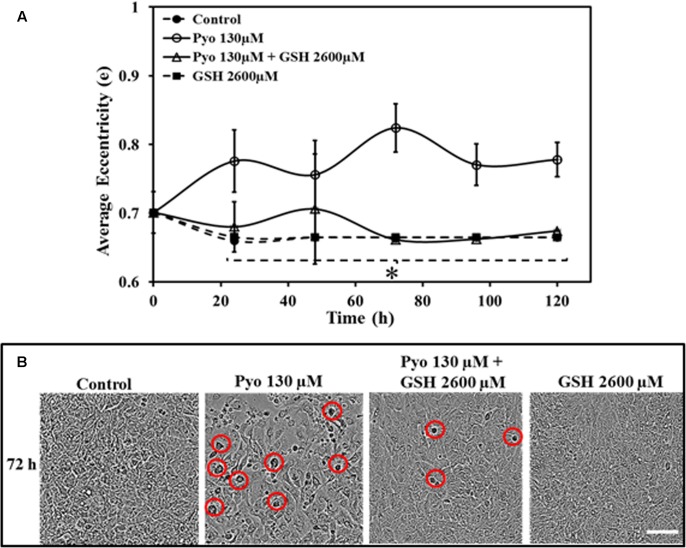
Effect of pyocyanin and GSH on A549 cell eccentricity over different time periods, monitored using IncuCyte Zoom live cell imaging. (A) Quantification of the average eccentricity of A549 confluence over 120 h. Control (untreated), GSH alone and pyocyanin + 2600 μM GSH-treated cells showed stable eccentricity, and the difference is significant in comparison to pyocyanin alone at all time-points. (B) Example showing 72 h images of A549 adherence, confluence and eccentricity in 96-well plates grown under different conditions. In comparison to the control, GSH alone and the pyocyanin + 2600 μM GSH, the pyocyanin only treated A549 cells showed considerably change in cell morphology (eccentricity-red circle). (A)
∗P < 0.05 when compared to A549 cells grown in presence of pyocyanin. Bar = 50 μm. Results are shown as mean ± SD and all experiments were conducted in biological triplicate (n = 3).